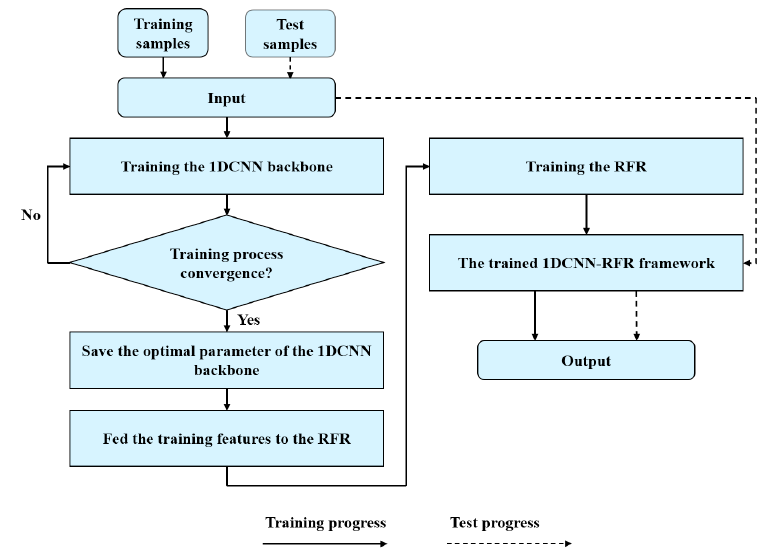
Figure 4. The workflow of the 1DCNN-RFR